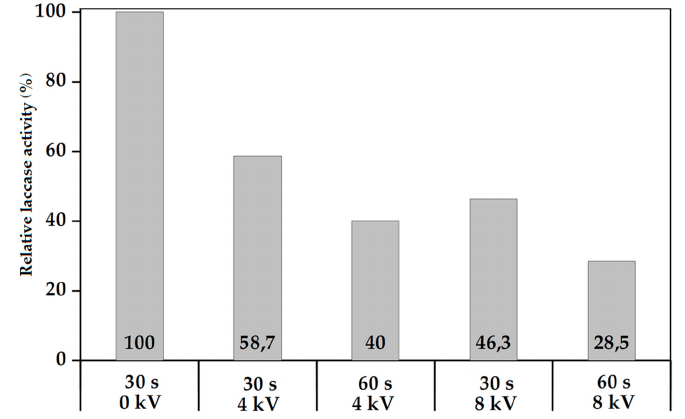
Figure 5. Experiment No. 2: Relative laccase activity (%) versus different applied voltages and plasma exposure times at constant V He = 10 L/min. 60 s activities are divided by 2 to normalize.